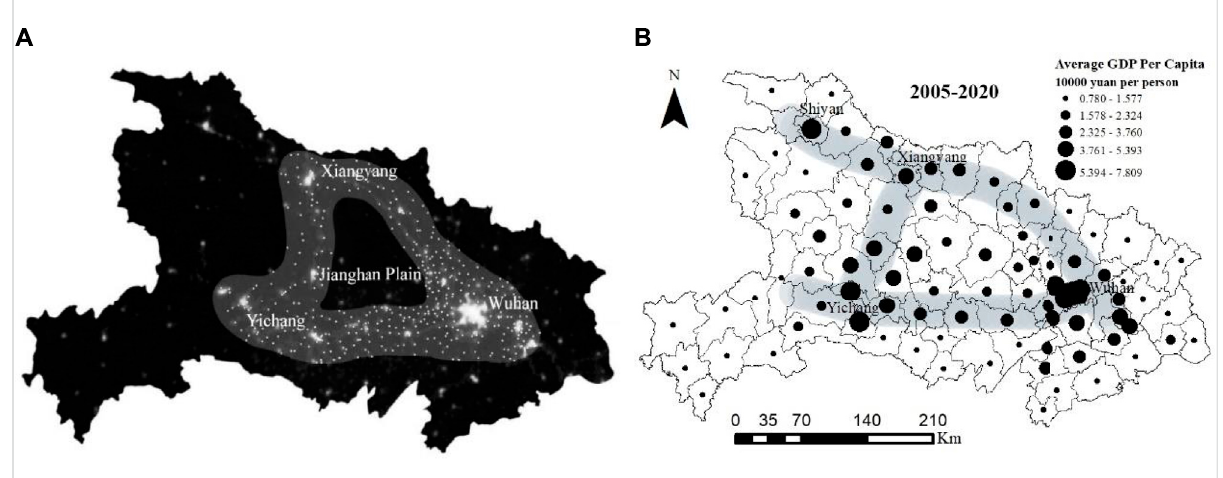
FIGURE 5 Fitting fi gure of city lights map and A-shaped point-axis structure in Hubei. (A) City Lights Map, (B) A-shaped Point-axis Structure.